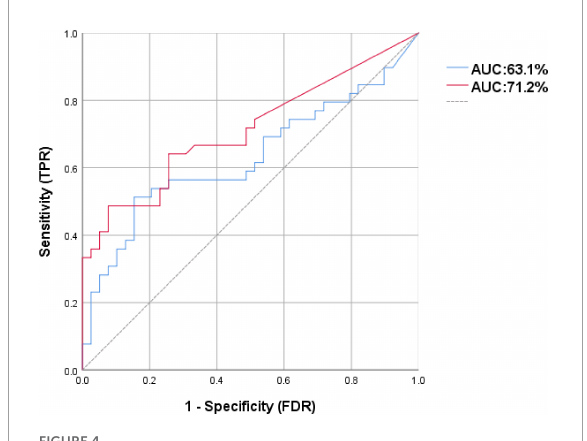
FIGURE4 The receiver operating characteristic (ROC) curve for predicting the occurrence of Parkinson’s disease (PD) in 78 samples: The dotted line represents the performance of the probabilistic model, the blue line represents the classification performance of f_ Bifidobacteriaceae , the red line represents the classification performance of the s_ Scardovia_inopinata , s_ Bifidobacterium_dentium , and s_ Scardovia_wiggsiae